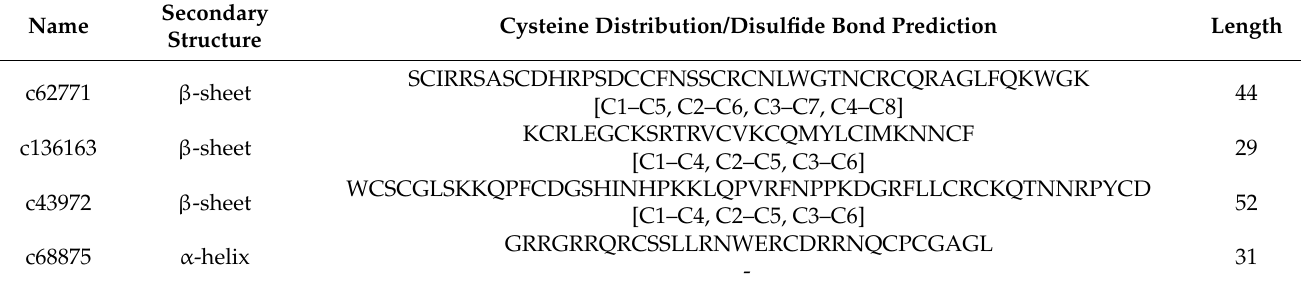
Table 4. Target peptide region expected of neuromodulatory